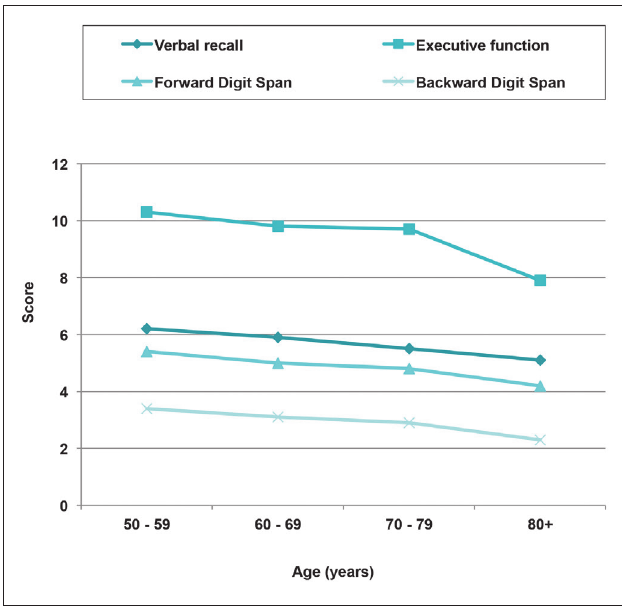
Fig. 1. Cognitive functioning among older South Africans per age